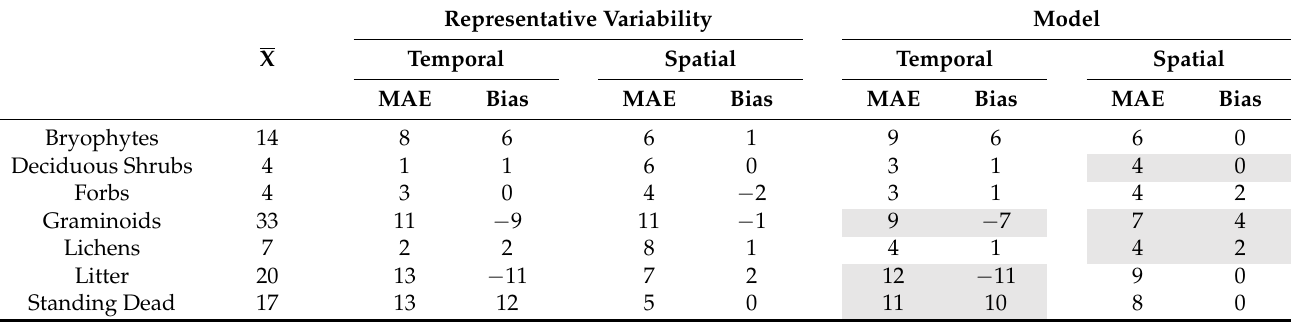
Table 4. Performance of the relative cover estimates of vegetation classes based on multinomial models that use plot-level photographs as predictors of field-measured (point frame) vegetation cover (model). For scale, measured relative cover (X) based on point frame measurements over all plots and years is provided. The cover of vegetation in each class was predicted for holdout years (temporal) and holdout plots (spatial). Model performance is illustrated by mean absolute error (MAE) and bias. Temporal variability is represented as the MAE of all plots sampled during the holdout years versus the mean of each plot for all holdout years (Figure S3); spatial variability is represented as the MAE of all holdout plots sampled during all years versus the mean of each year for all holdout plots (Figure S4). Values are shaded if the modeled cover in the respective class had a lower MAE than the representative variability. Representative Variability Model Temporal Spatial